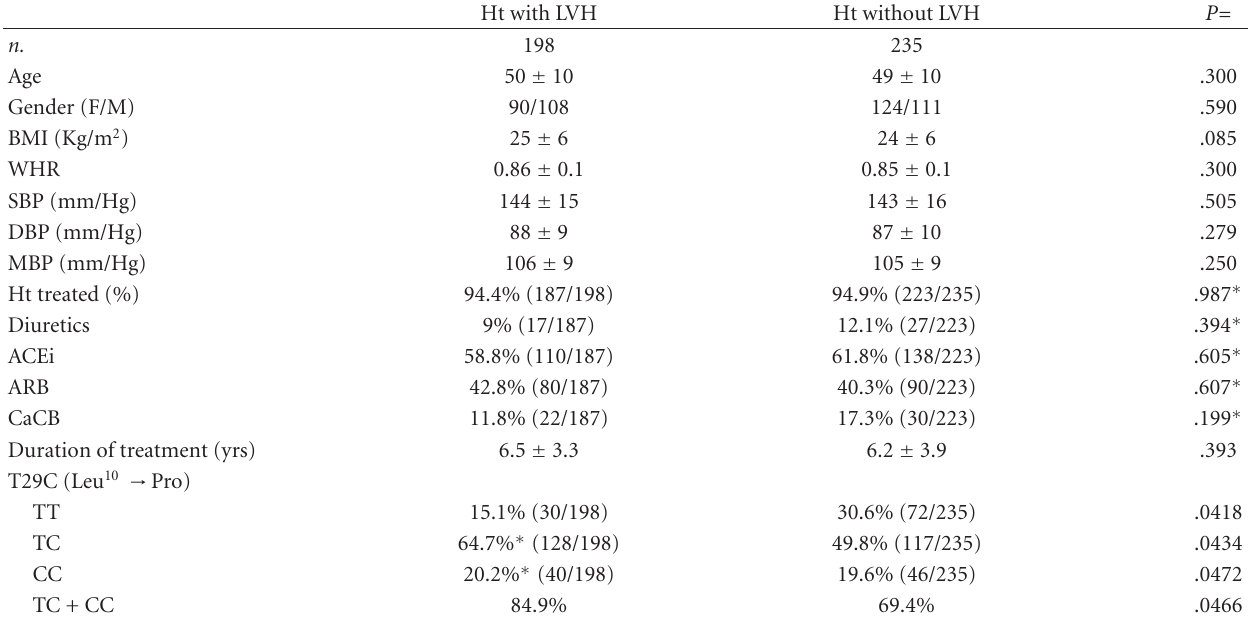
Table 1: Clinical characteristics and distribution of Leu 10 → Pro 10 genotypes in hypertensives (Ht) with and without left ventricular hypertrophy